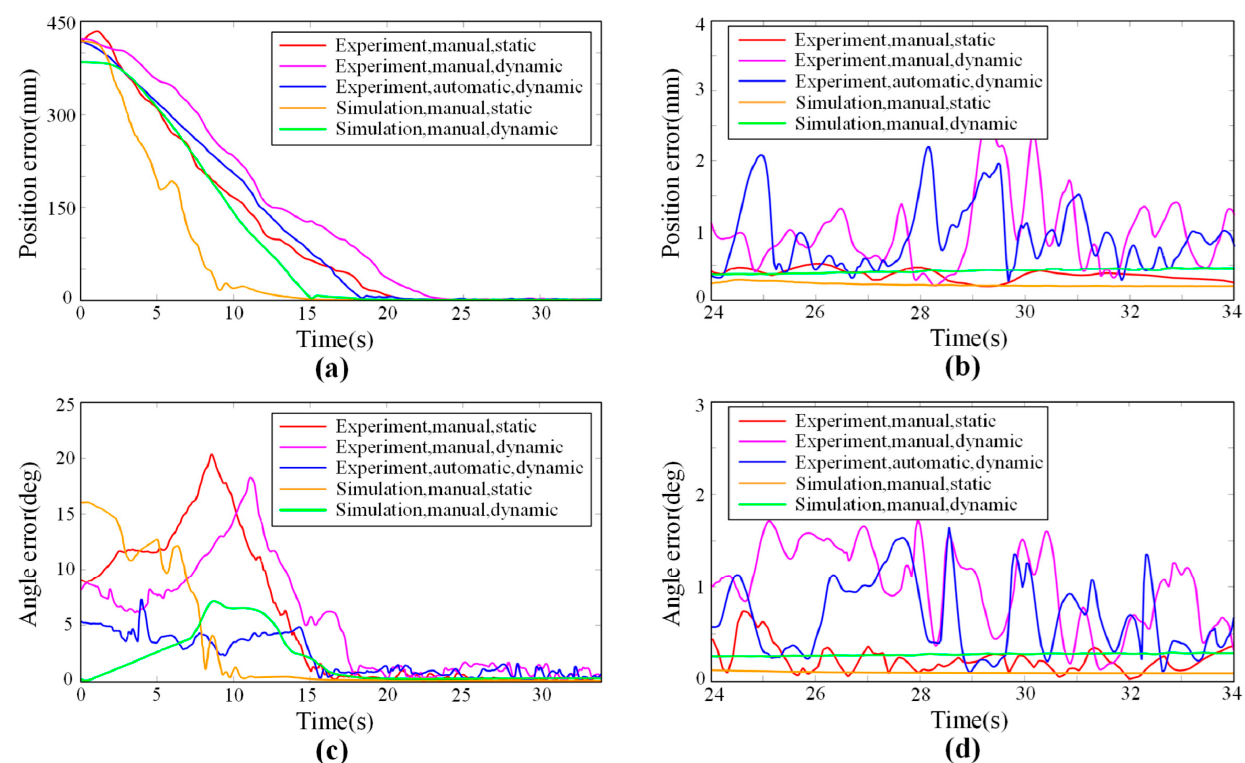
Figure 21. The errors between surgical tool and target during some groups of experiments or simulations: ( a ) Position errors of overall process. ( b ) Local enlargement of position errors during the following stage. ( c ) Orientation errors of the overall process. ( d ) Local enlargement of orientation errors during the following stage.